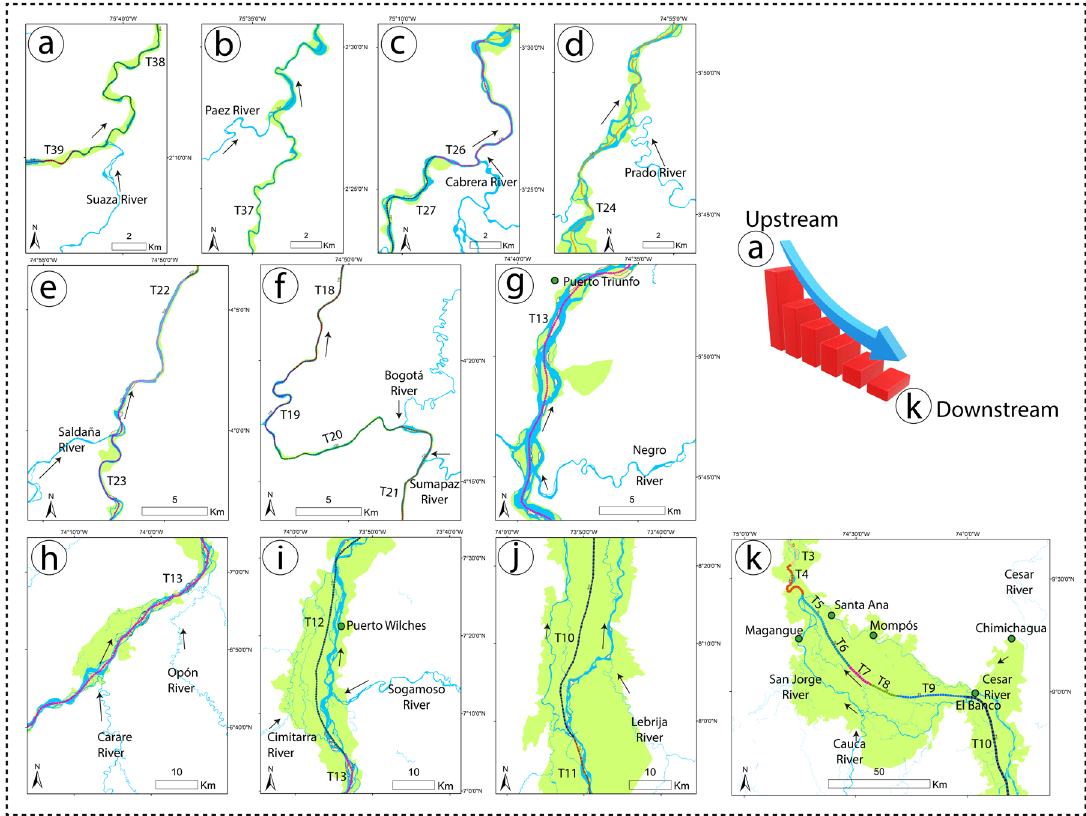
Figure 10. Magdalena case study. Stretches (from upstream, top left, to downstream, bottom right) where a significant change of contributing basin area occurs, i.e., a tributary comes in (figure k scale 1:3,200,000 approx.; all other zooms scale 1:500,000 approx.). The figure also shows active channels (blue), VB (light green), islands (dark green), and main bars (dotted yellowish) according to official IGAC information. Colors and numbering (Txy) along the river identify the reaches.